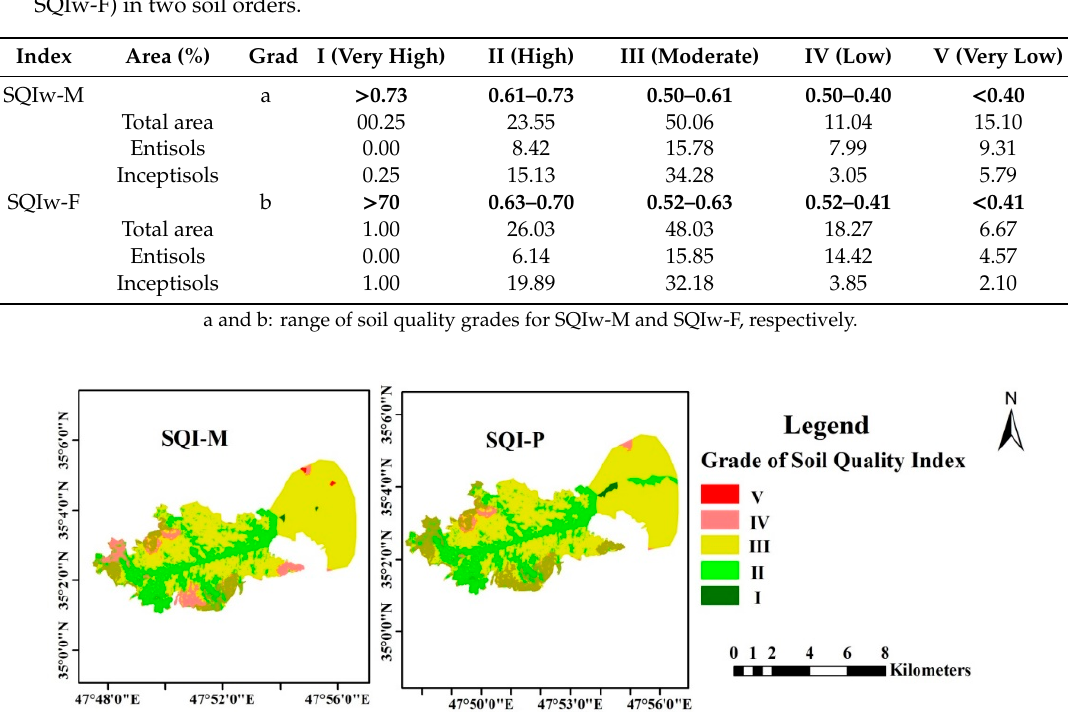
Table 7. Results of independent samples t-test for soil properties and SQIs.